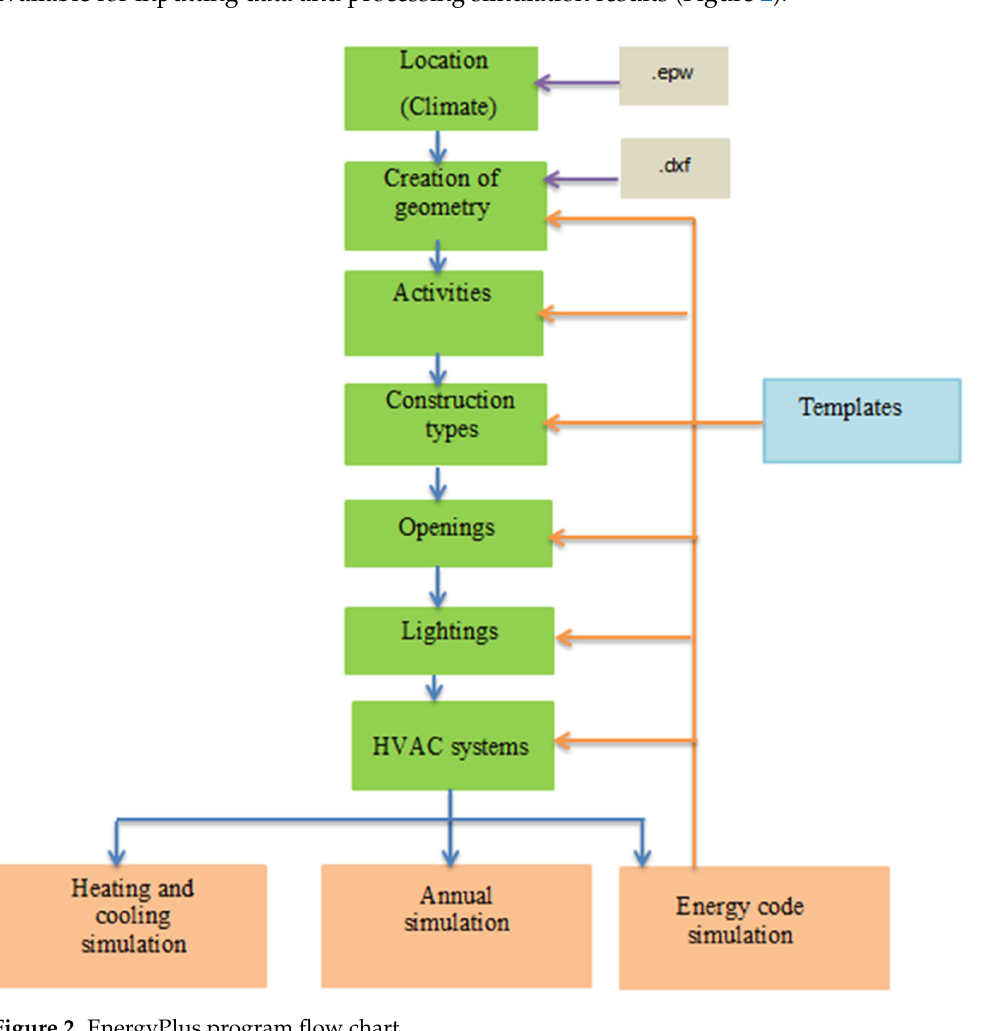
Figure 2. EnergyPlus program fl ow chart.